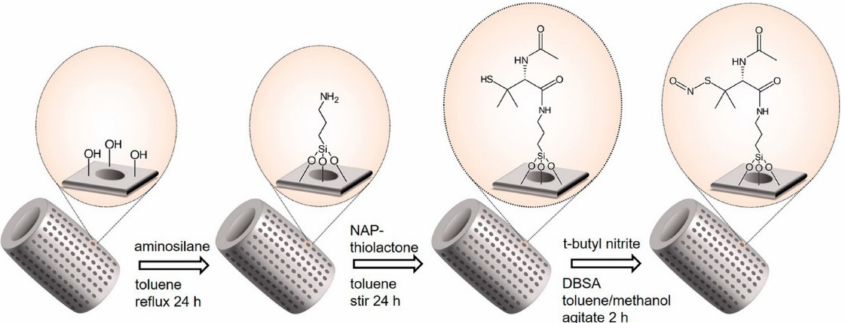
Figure 9. Graphical abstract representing an SEM image of a vitamin B 12 modified diatom (DEMs-B 12 -1) anchored to a HT29 colonic cancer cell and the corresponding scheme. Reproduced from [73], by permission of The Royal Society of